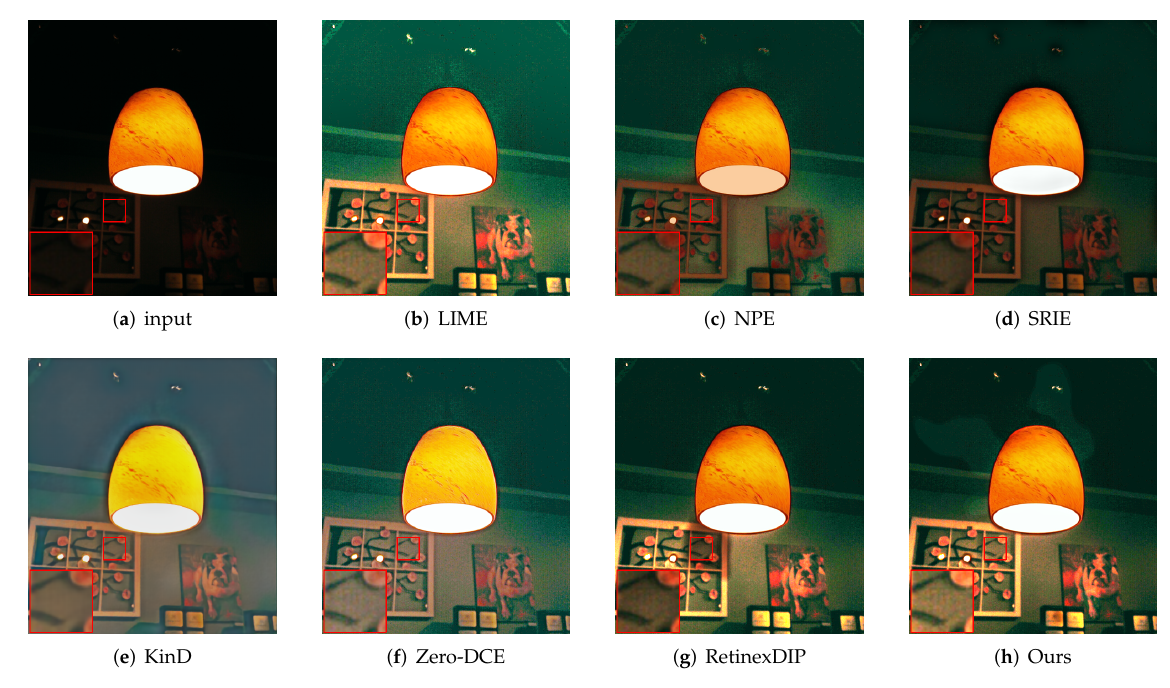
Figure 5. Comparisons of enhanced images. Red boxes indicate the obvious differences. Compared with other methods, our method does not have the problems of overexposure and artifacts.